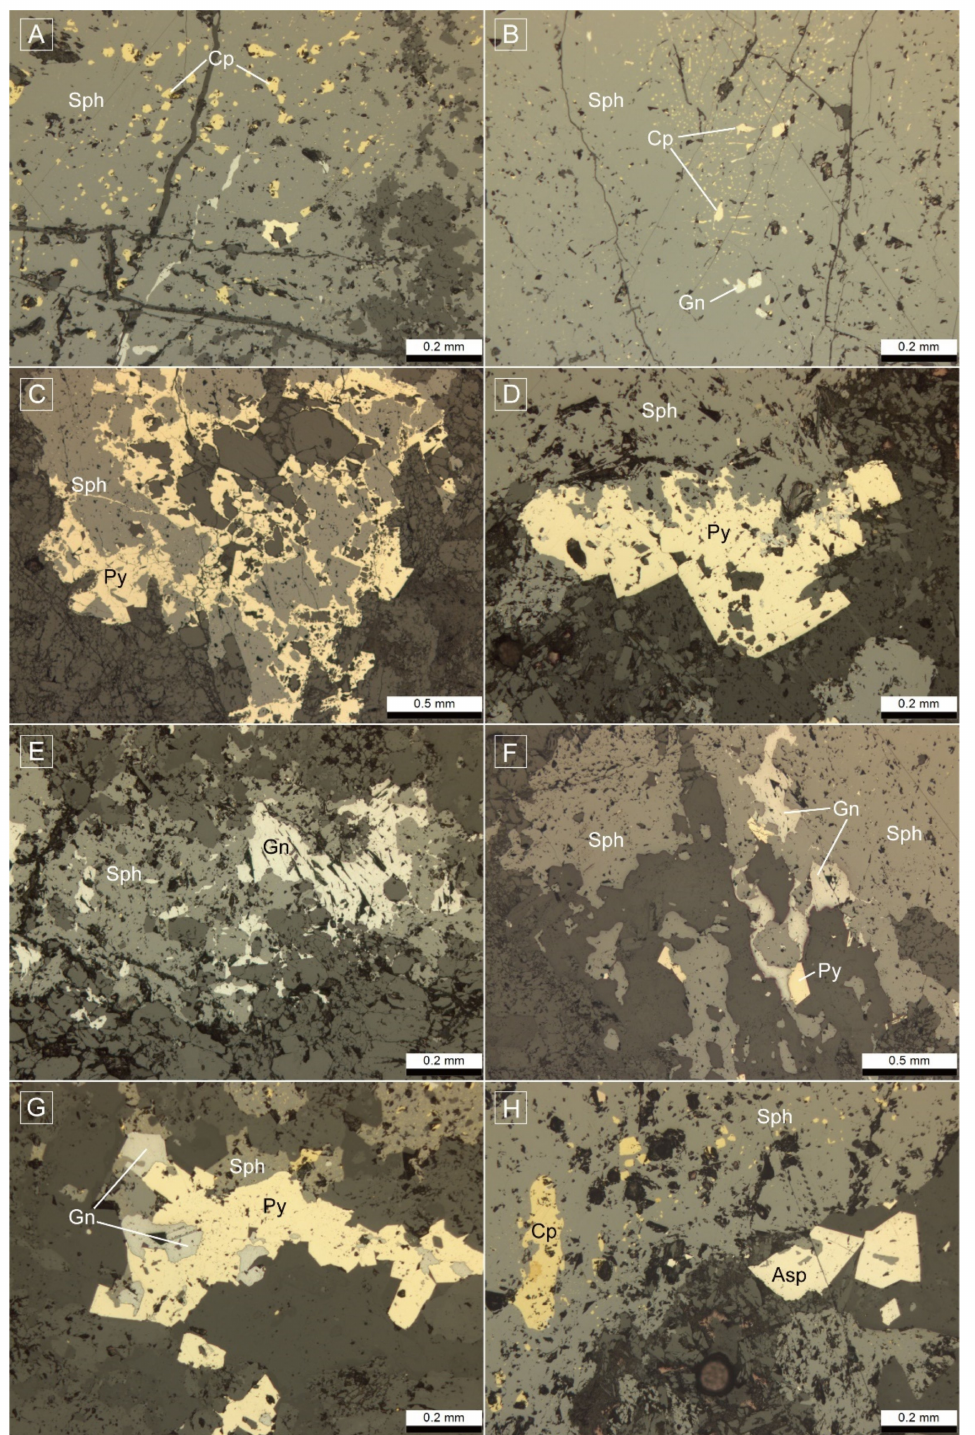
Figure 15. Microphotographs under reflected microscope. ( A , B ) Chalcopyrite (Cp) and galena (Gn) inclusions within sphalerite (Sph). ( C , D ) Pyrite (Py) replaces sphalerite. ( E , F ) Galena replaces sphalerite. ( G ) Galena replaces pyrite. ( H ) Arsenopyrite (Asp) is associated with